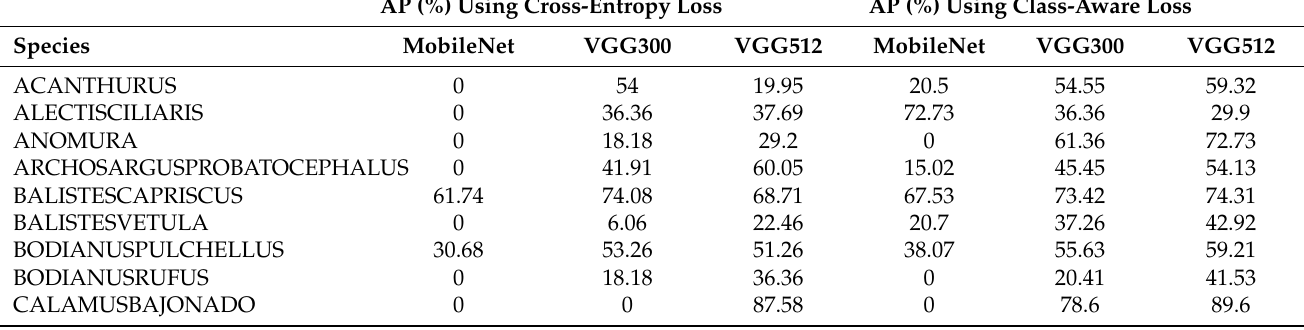
Table A1. AP of the original cross-entropy and proposed class-aware losses for each fish species. VGG300 is for the VGG16 backbone with a resolution of 300 × 300, and VGG512 is for a resolution of 512 × 512. The MobileNet and VGG are backbone networks, and the detection head is SSD for both